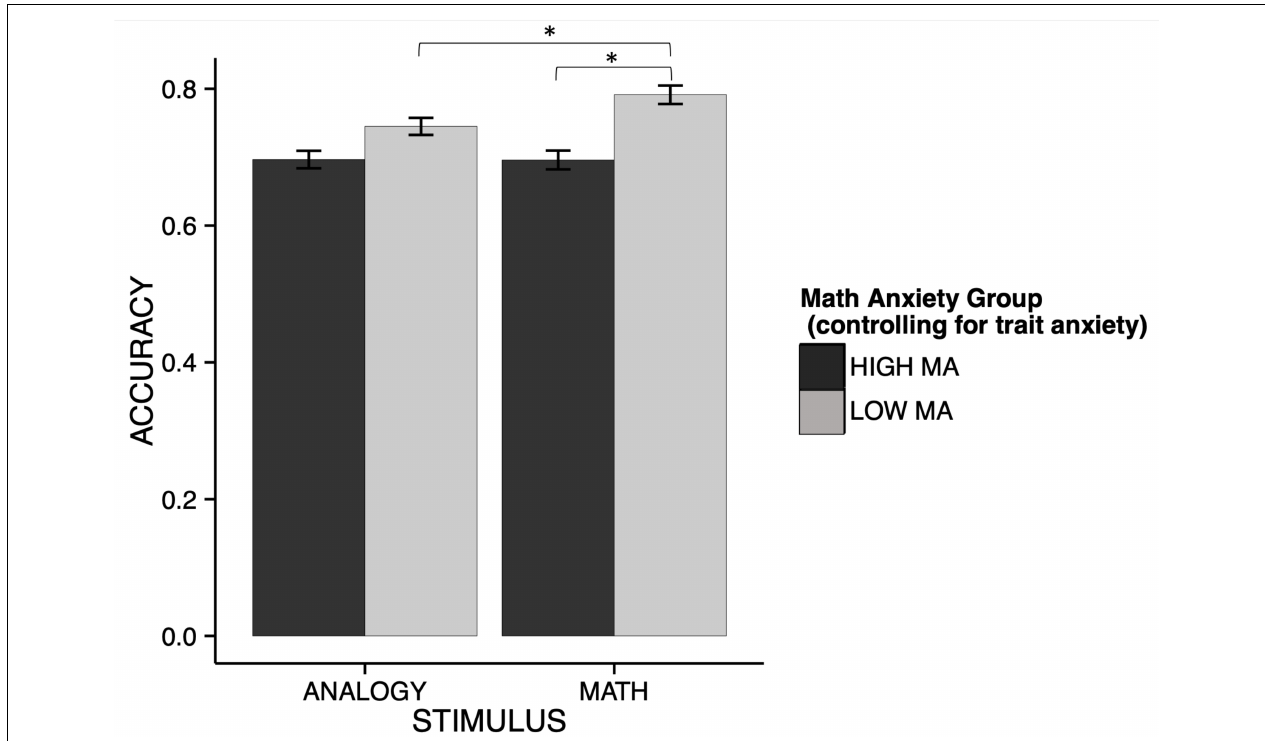
FIGURE 2 | Interaction between math anxiety and stimulus type for accuracy. The pattern of accuracy across stimulus type differs on the basis of math anxiety. Overall, the LMA group shows higher accuracy than the HMA group [ χ 2 (1) = 13.83, p < 0.001], however, this performance gap between groups interacts significantly with stimulus type [ χ 2 (1) = 4.03, p = 0.045]. For the analogy condition, the LMA group slightly outperforms the HMA group. This disadvantage for high math anxiety is even greater in the math condition, indicating that math anxiety creates an additional performance decrement in the math condition for HMA individuals. *indicates pairwise comparisons that are statistically significantly different at p <